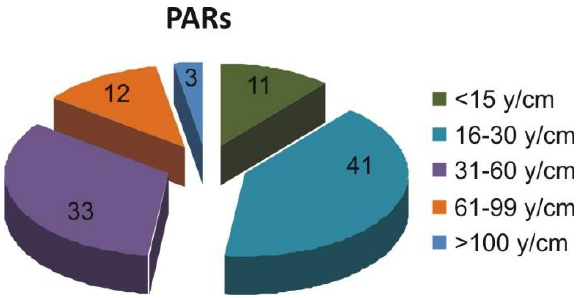
Figure 4. Distribution of the peatlands considered, grouped into different classes on the basis of vertical peat accumulation rates (PARs).